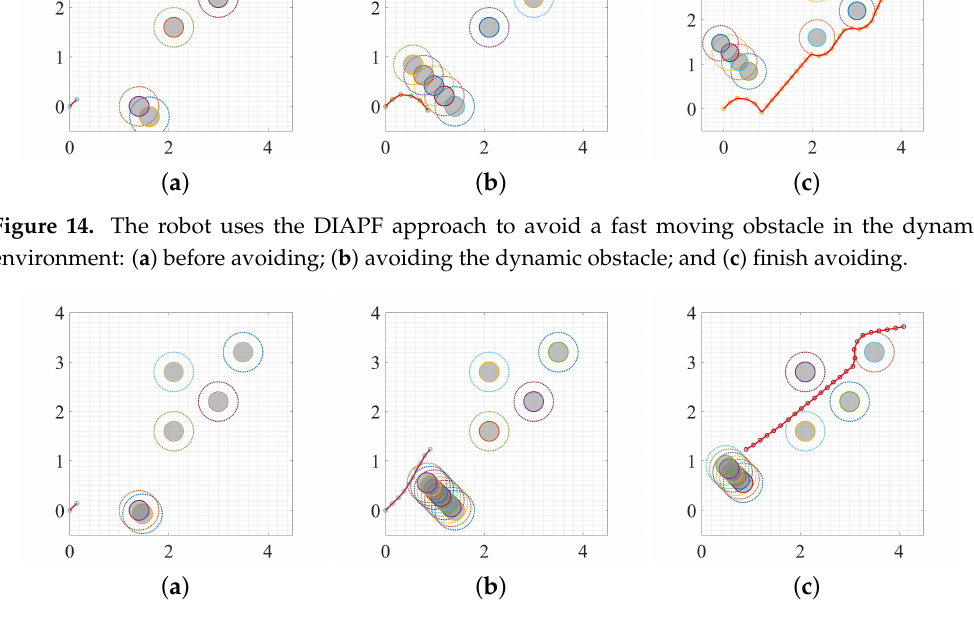
Figure 15. The robot uses the DIAPF approach to avoid a slow moving obstacle in the dynamic environment: ( a ) before avoiding, ( b ) avoiding the dynamic obstacle; and ( c ) finish